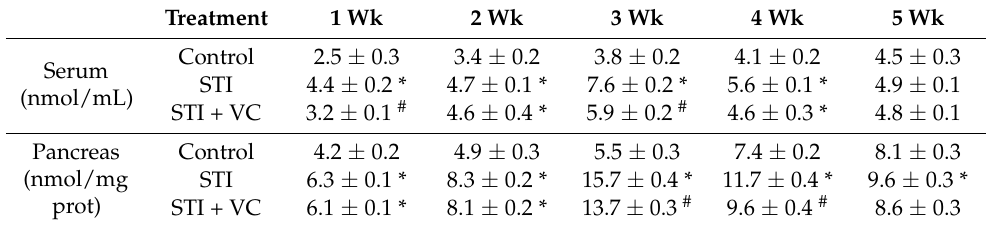
Table 4. MDA content in serum and pancreas.